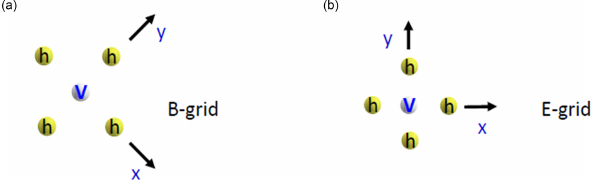
Figure 2. (a) Arakawa’s B-grid in GEF, (b) Arakawa’s E-grid in regional Eta